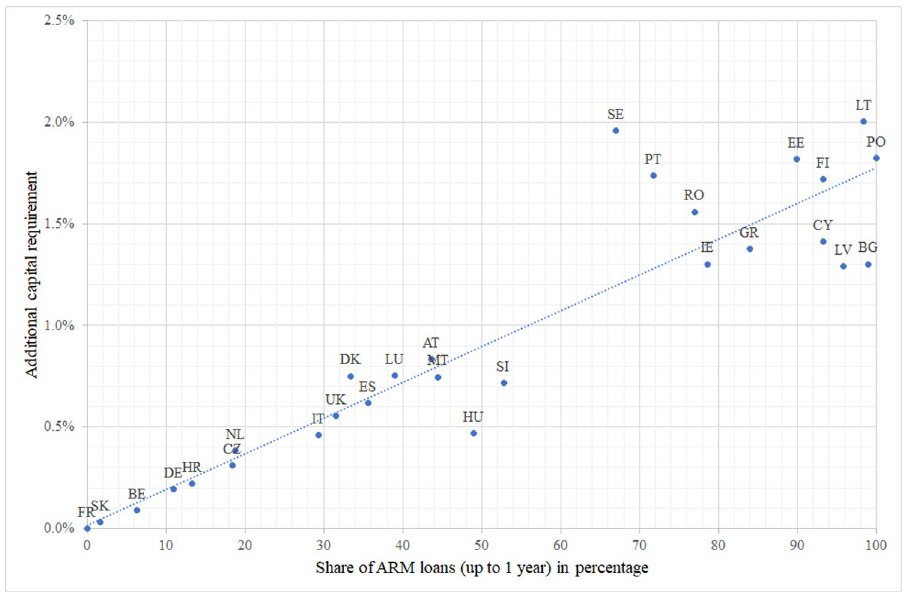
Fig 2. Additional capital need relative to the total portfolio value Δ CR/V in EU countries, November 2020. The additional capital need depends mostly on the share of ARM loans. Due to other parameters (interest rates, maturities, etc.), some countries might be above or below the trendline.